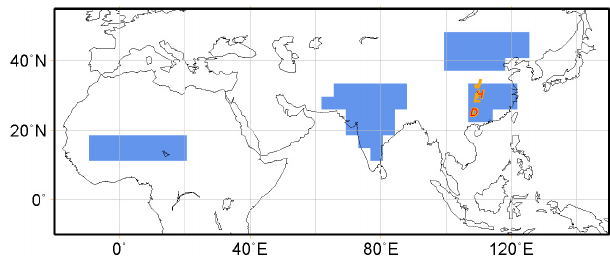
Figure 1. Definition of the different monsoon sub-regions used in this study (shaded) and the locations of caves in the East Asian mon- soon region (letters) for which speleothem records exist, i.e. Dongge cave (D, 25.32 ◦ N, 108.09 ◦ E; Wang et al., 2005), Heshang Cave (H, 30.45 ◦ N, 110.42 ◦ E; Hu et al., 2008), Lianhua Cave (L, 29.29 ◦ N, 109.32 ◦ E; Cosford et al., 2008), and Jiuxian Cave (J, 33.34 ◦ N, 109.6 ◦ E; Cai et al.,